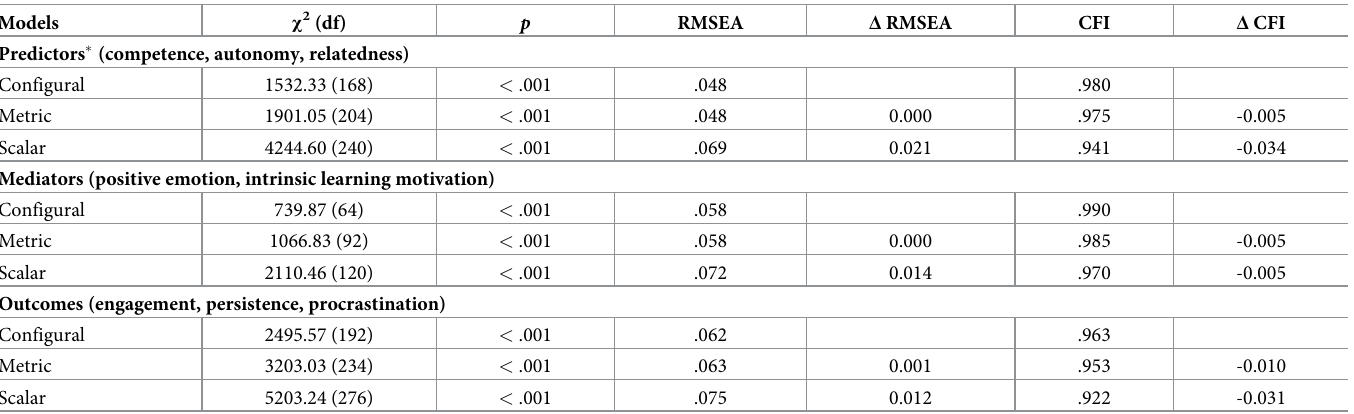
Table 4. Measurement invariance testing across countries for the confirmatory factor analytic measurement models for the predictors, mediators, and the